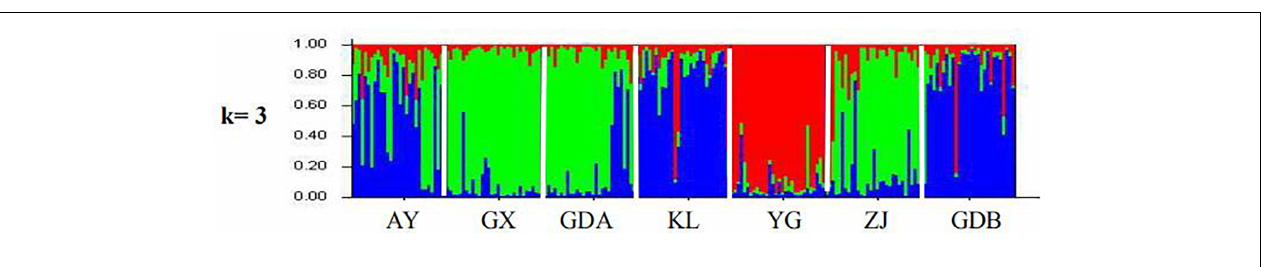
FIGURE 5 | Clustering analysis of cultured and wild populations of M. rosenbergii